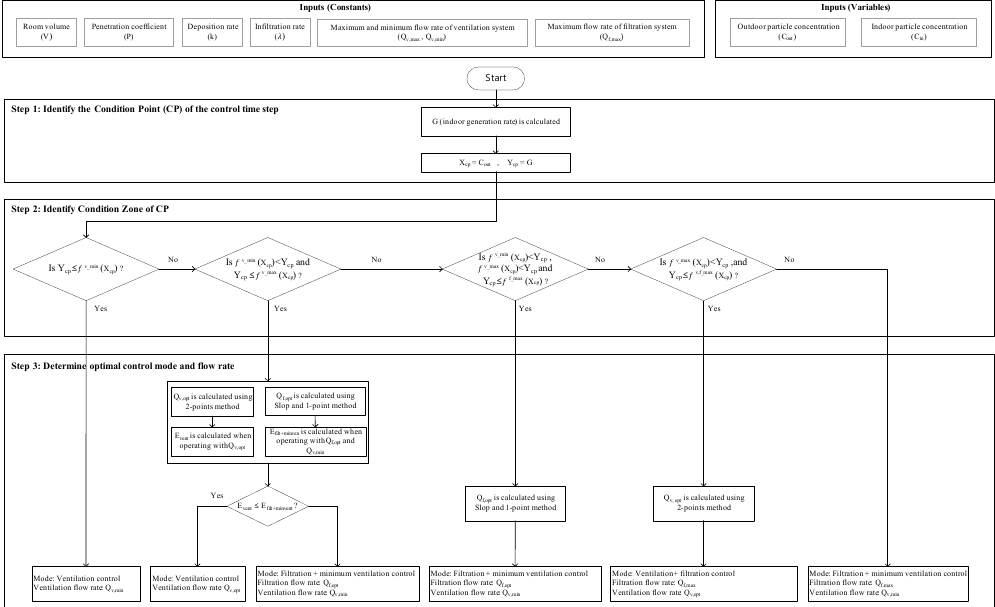
Figure 11. Optimization algorithm of the ventilation and filtration system.